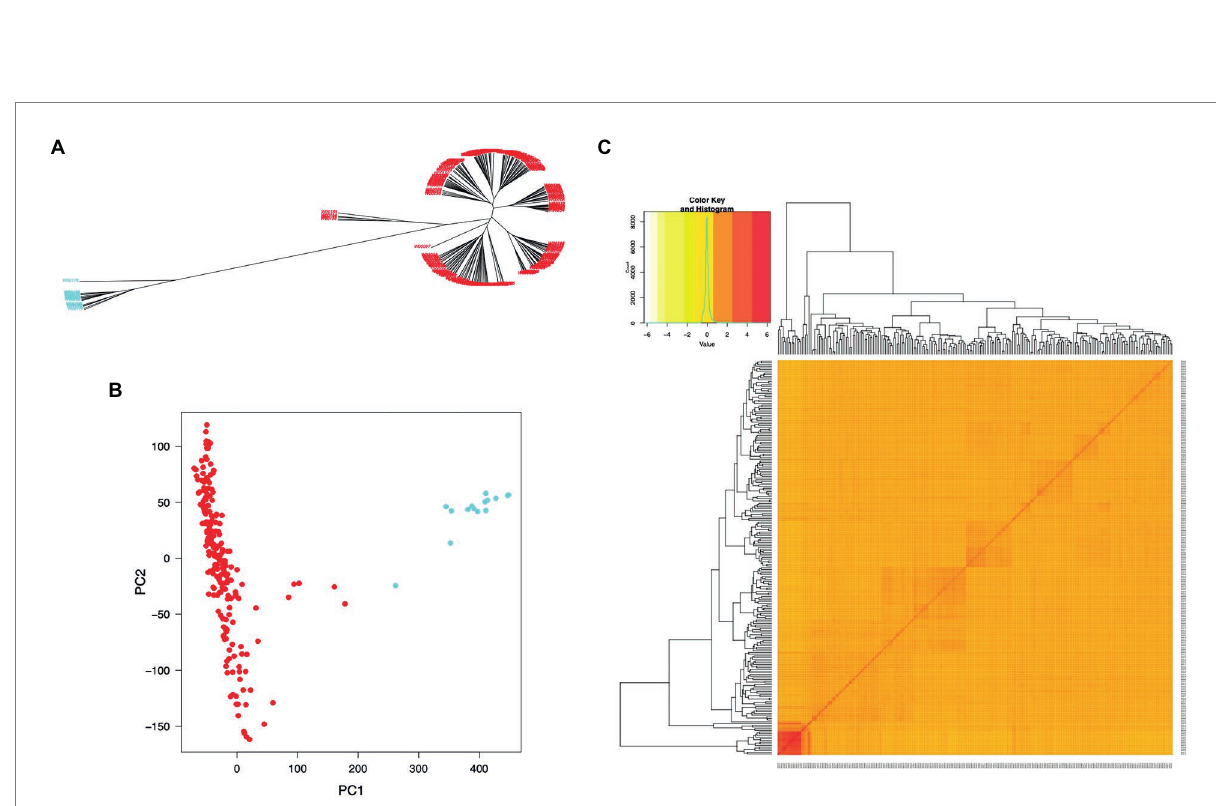
FIGURE 4 Population structure and individual relatedness of 239 rice accessions. (A) Neighbor-joining tree (NJ-tree). (B) Two-dimensional plots of PC1 versus PC2. Red and blue colors in (A) and (B) denote rice accessions in indica and japonica groups, respectively. (C) Heatmap of the hierarchical kinship matrix. Relatedness values are represented by color codes in yellow (the highest) and red (the